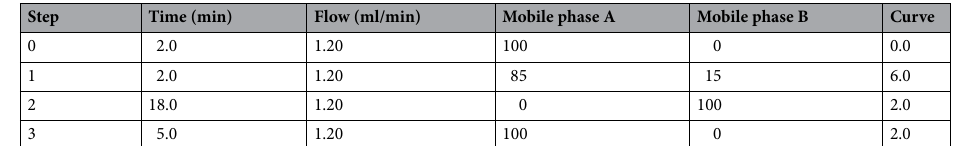
Table 1. Gradient elution program for high-performance liquid chromatography analysis of extracts from hair samples to determine the basis of biofluorescence in springhare ( Pedetes capensis